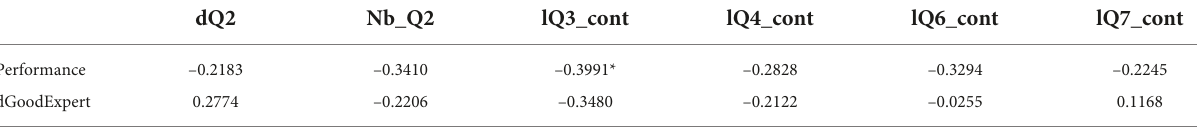
TABLE 5 Correlation table of items of Past Experience